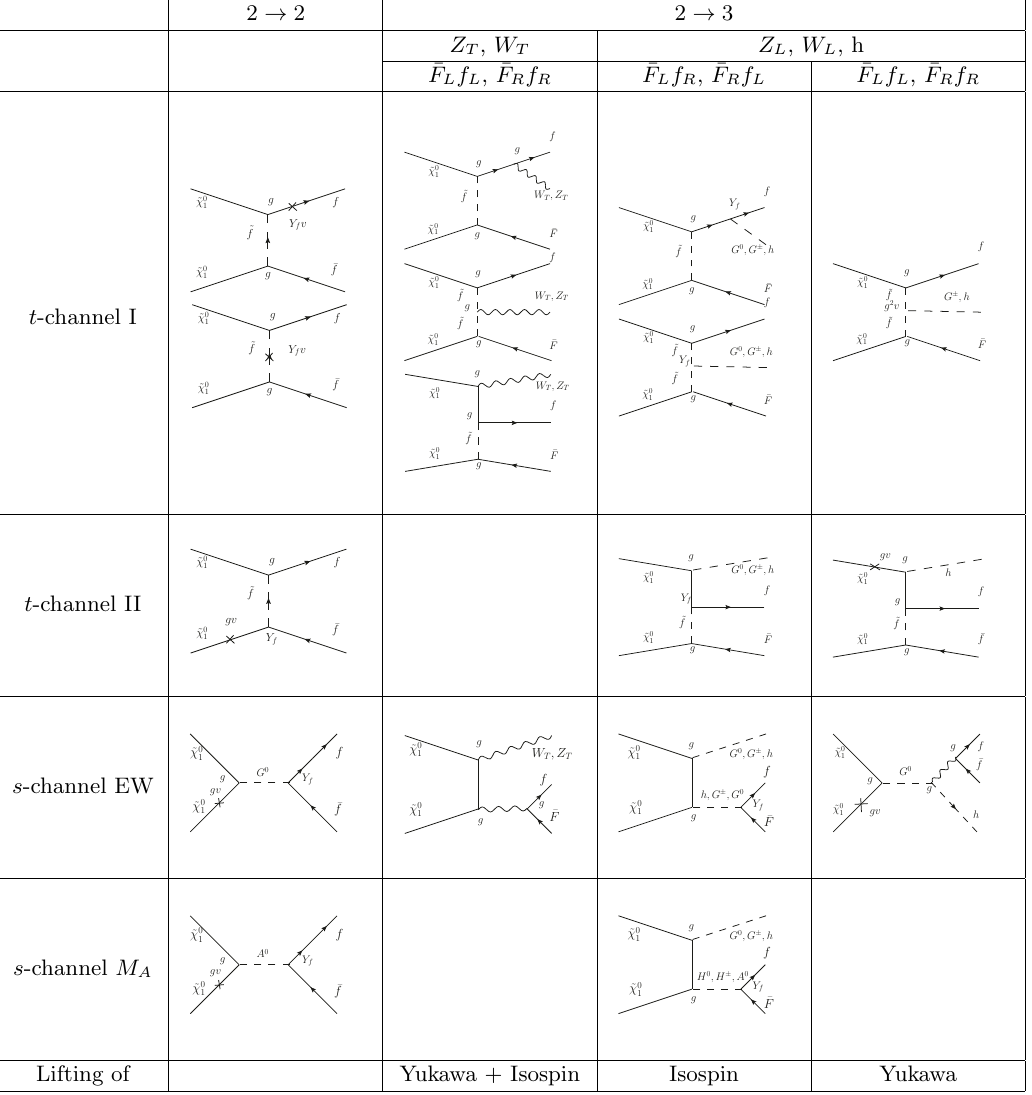
Lifting of Isospin Yukawa Table 3 . Diagrams for annihilation into fermions (cid:22) ff and B (cid:22) Ff (for B = W; Z; h ) in the gauge restoration limit v EW 0. The rows correspond to the four gauge-invariant subsets of diagrams ! that can be discriminated in this limit (see appendix A.3 for details). The (cid:12)rst column corresponds to the two-body process, and the other columns show various three-body processes. The diagrams shown in the second column lift both Yukawa and isospin suppression. The diagrams in the third column lift only isospin suppression, and in the fourth column only Yukawa suppression. We show only one representative diagram for each topology (ISR/FSR/VIB) and suppression mechanism. The coupling factors attached to vertices and mass/mixing insertions give the scaling with y f , v EW and g of each diagram (for Bino- or Wino-like neutralinos; modi(cid:12)cations for Higgsino-like neutralinos are described in appendix A.3). Note that contributions with W T emitted via ISR (second column, (cid:12)rst and third row) exist for Wino- or Higgsino-like neutralinos; those with Z T emitted via ISR occur only for a Higgsino-like neutralino.